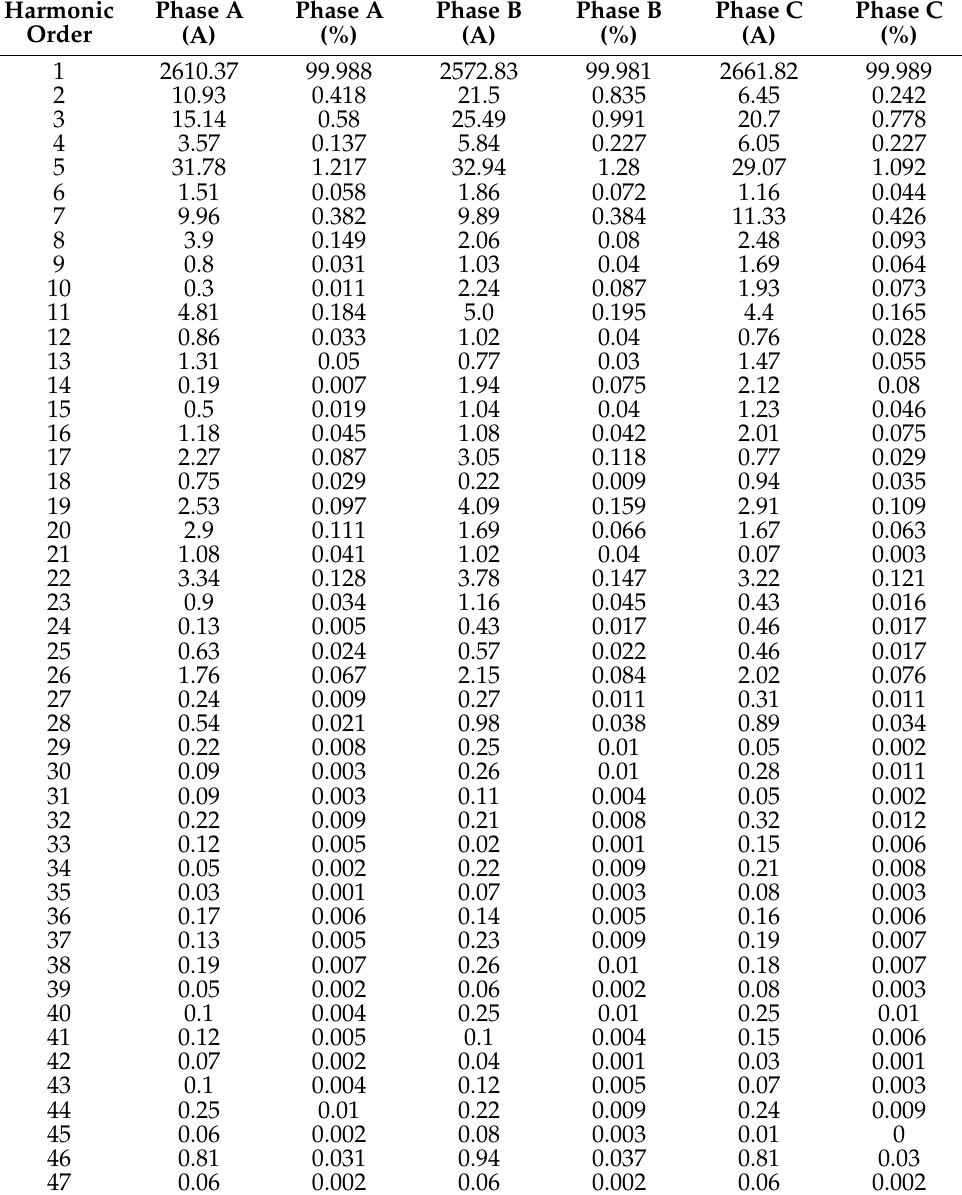
Table A3. Inverter data—harmonic